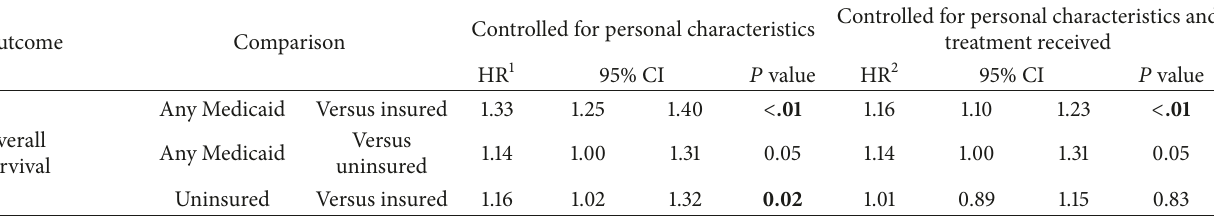
Table 3: Adjusted hazard ratios for all-cause survival by insurance status.